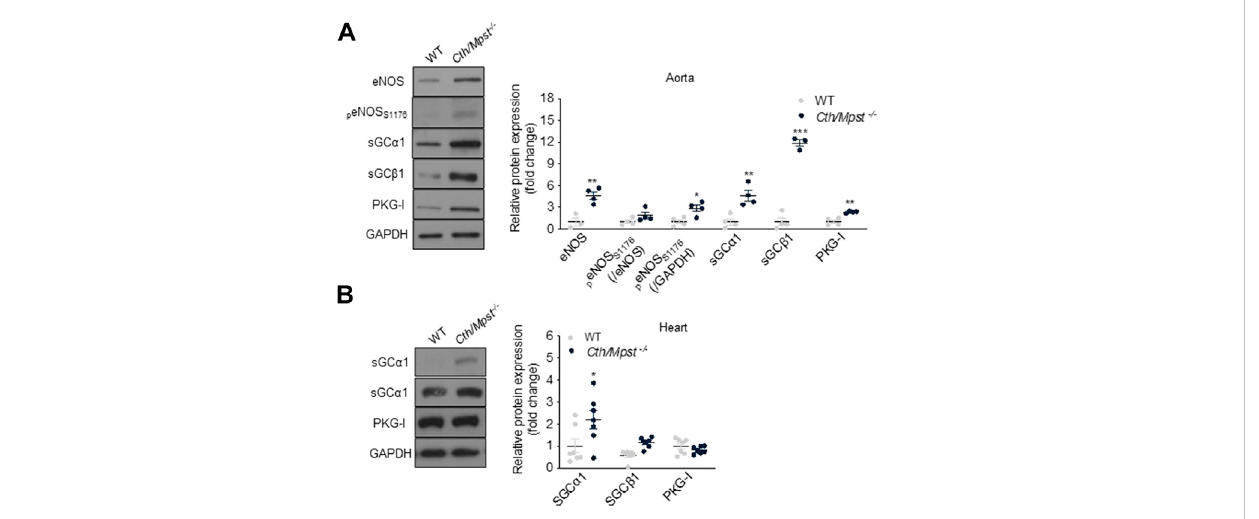
FIGURE 7 Cth/Mpst double ablation results in upregulation of eNOS/sGC signaling in aorta. Representative western blots and quanti fi cation of eNOS, sGC α 1,sGCB β 1andPKG- Ι proteinlevelsin (A) aortaand (B) heartproteinlysatesofWTand Cth/Mpst − / − mice.ProteinexpressionispresentedasratiooverWT group. Data were normalized to GAPDH or eNOS and presented as means ± S.E.M. * p < 0.05, ** p ≤ 0.01 and *** p ≤ 0,001, (A) N = 3-4 and (B) N = 6-7 mice per group.